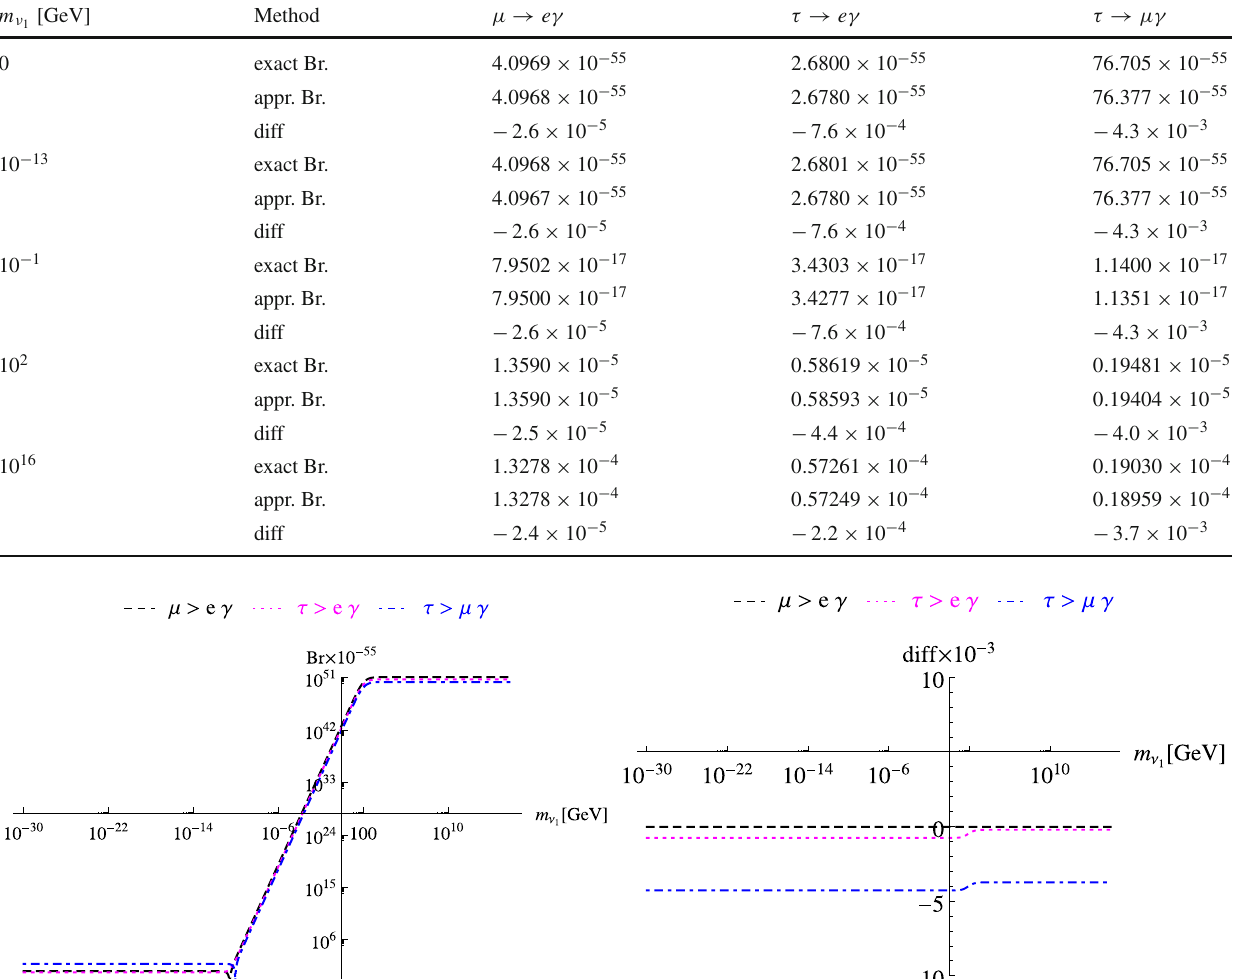
Fig. 2 Exact branching fraction (left) and difference between exact and approximate results (right) as functions of m ν chose from very small to very large values. All input parameters and definitions are as in the caption of Table 2